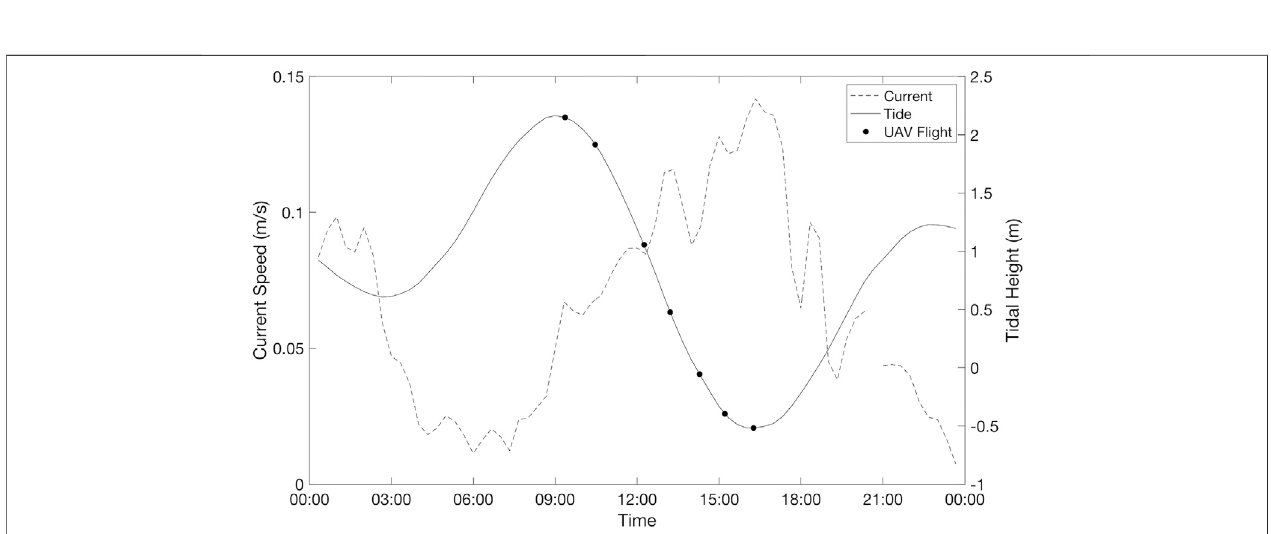
FIGURE 9 | Temporal variations in tidal height and current speed during each fl ight of the single-day Arroyo Quemado tidal survey.